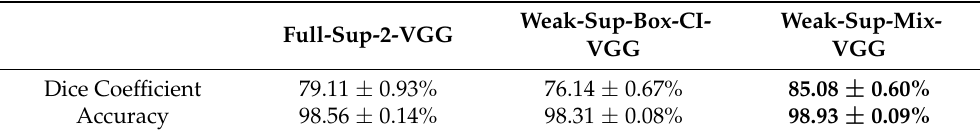
Table 4. Average test-set scores and standard deviation using 10-fold cross-validation on the Polyp- Box-Seg images. Models are initialized with VGG16 weights and then trained as described in the text.